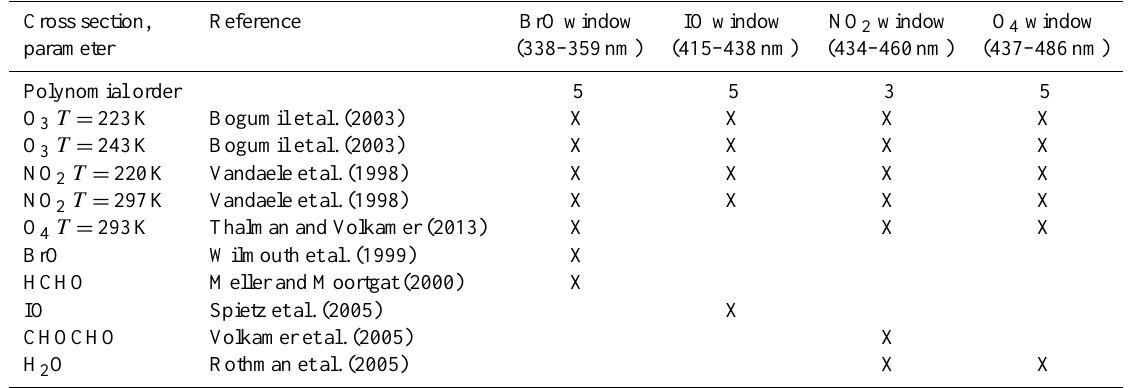
Table 1. Overview of DOAS settings. Cross